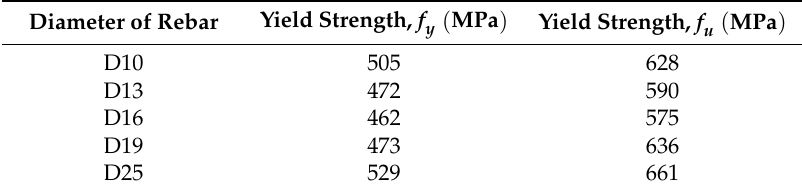
Table 2. Material test results of the